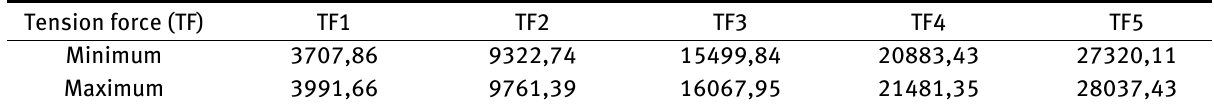
Table 1: Tension forces [ ? ] Tension force (TF) TF1 TF2 TF3 TF4 TF5 Minimum